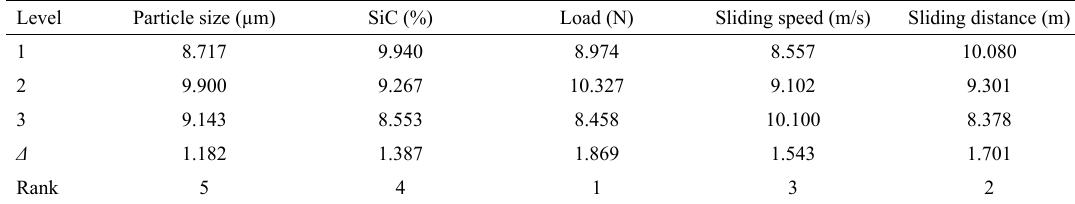
Table 6. S/N ratio responsefor co-efficient of friction (smaller is better)